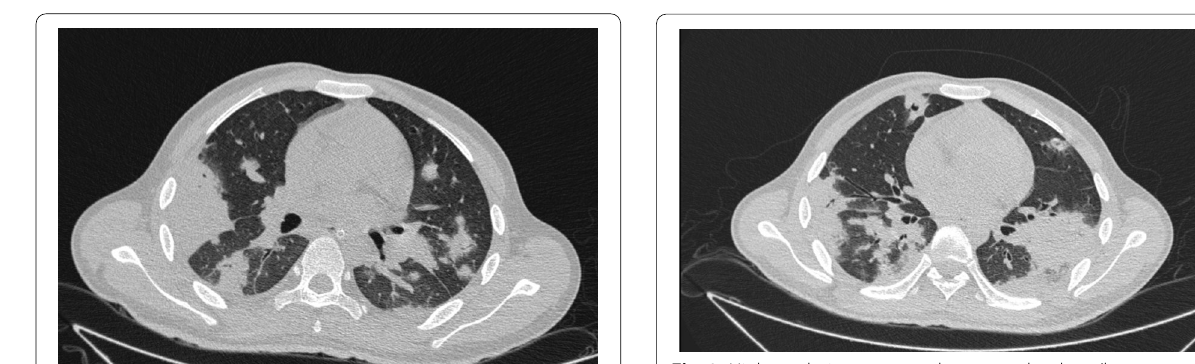
Fig. 2 High-resolution computed tomography chest (lung window) on day 17 of admission redemonstrates areas of air space opacifications with interval appearance of internal areas of breakdown